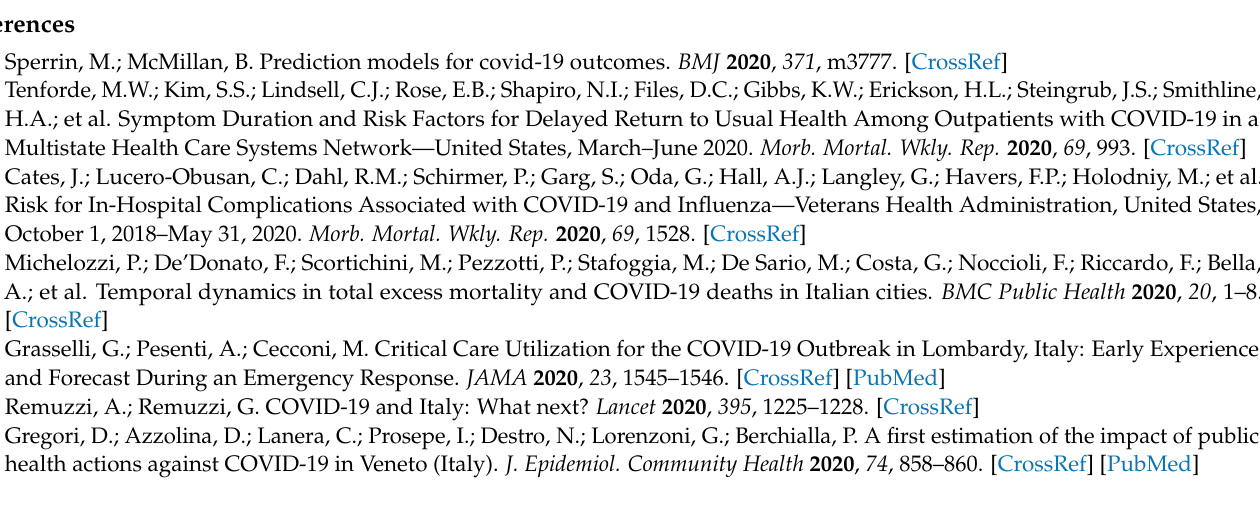
MLTs employed to predict in-hospital death. Table S2: Variable importance plots for each Random Forest developed. Figure S1. ROC, sensitivity, and specificity measures of the null model and the random